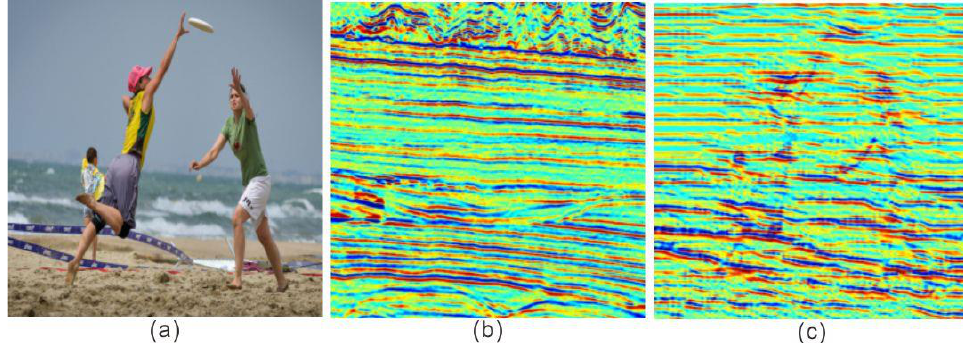
Figure 8. Drafting network training results. Transferring the global pattern at low resolution, the result image has only a fuzzy contour; the leg and other details are seriously lost; and the overall color is dark. ( a ) Content; ( b ) Style; ( c ) Drafting network training transfer of the overall style of the graph ( b ) while ensuring that the content of the graph ( a ) as far as possible was not lost.